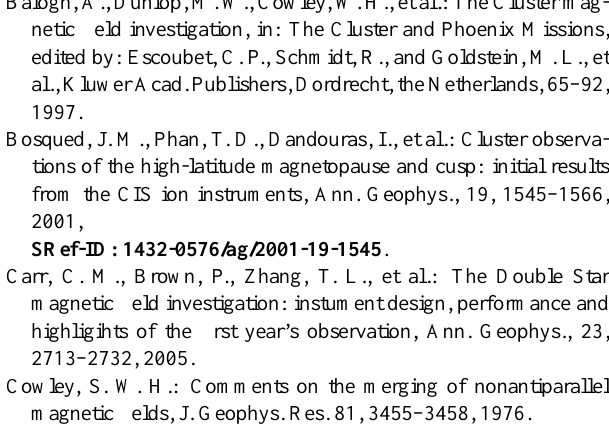
location of reconnection X-line.